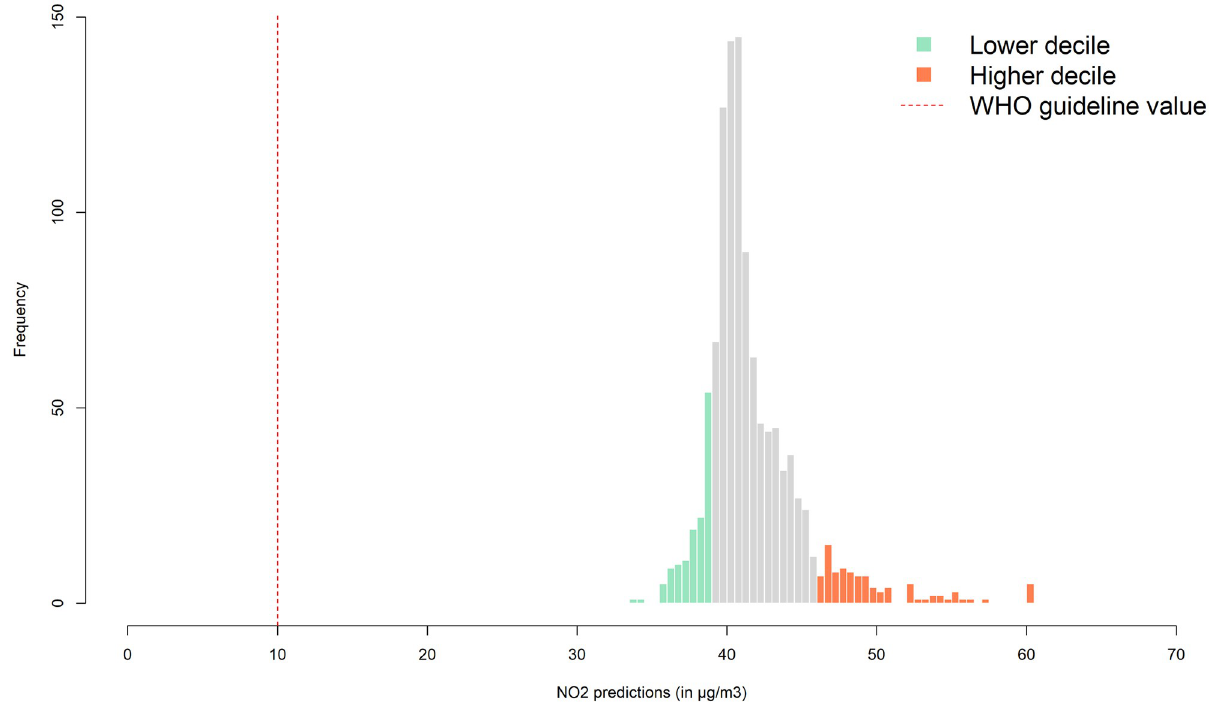
Fig 2. Range and frequency of predicted NO 2 concentrations at children’s home